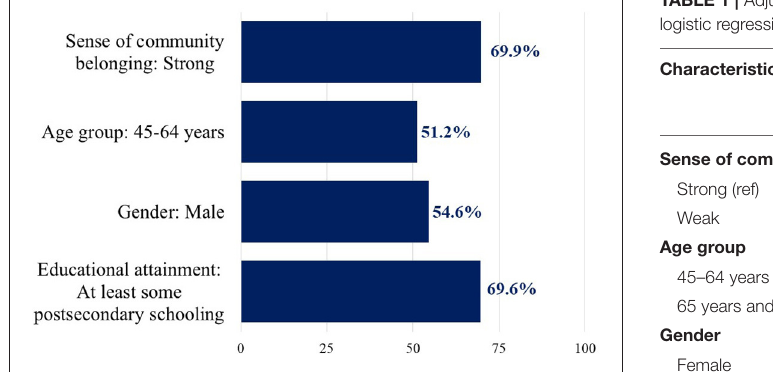
FIGURE 1 | Percent of the Canadian population 45 years and over living with diabetes by selected characteristics. Data weighted for population representation. Source: Linked Canadian Community Health Survey—Discharge Abstract Database ( n = 13,580).